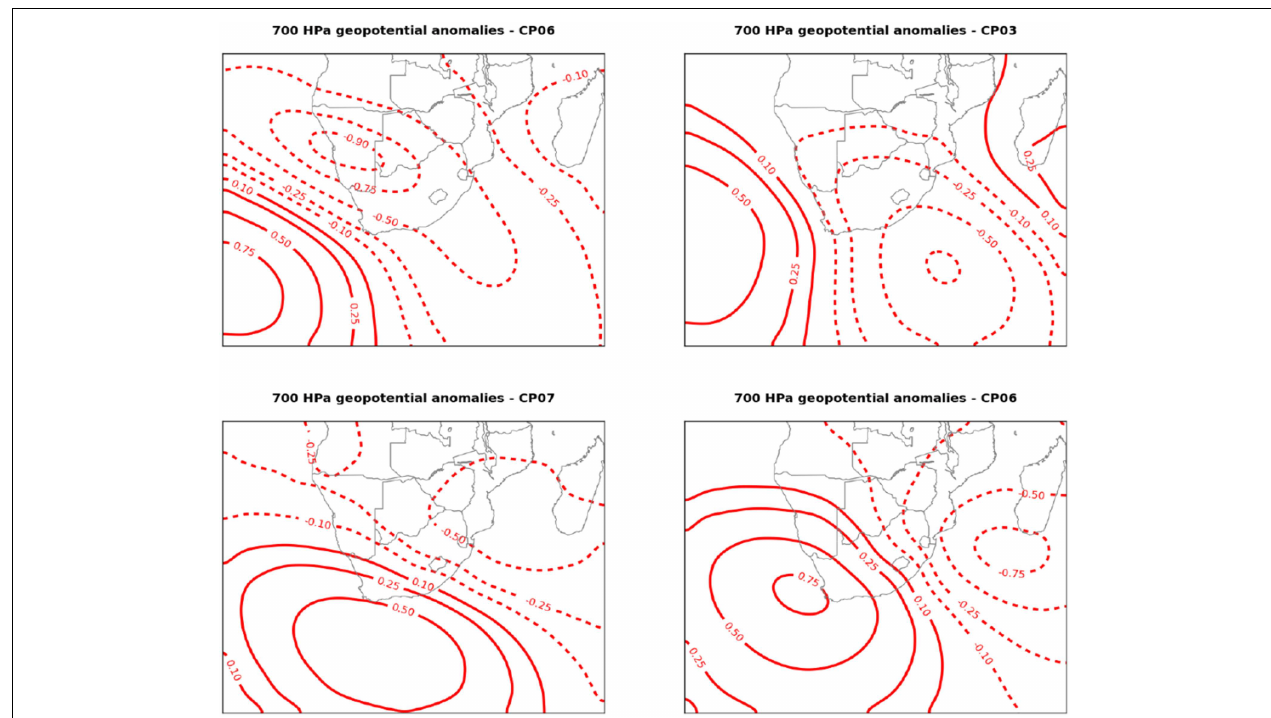
FIGURE 3 | Two pairs of CPs: top two similar to each other and the bottom two likewise, selected from the CPs chosen on 2 sets of gauges in Region 6.